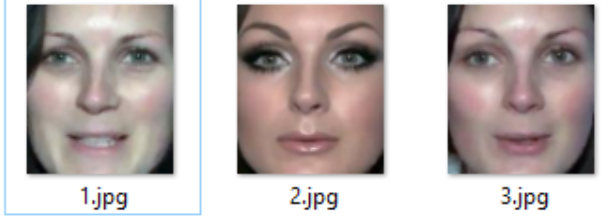
Figure 9. Training images for Person-1 for VMU Image Benchmark.